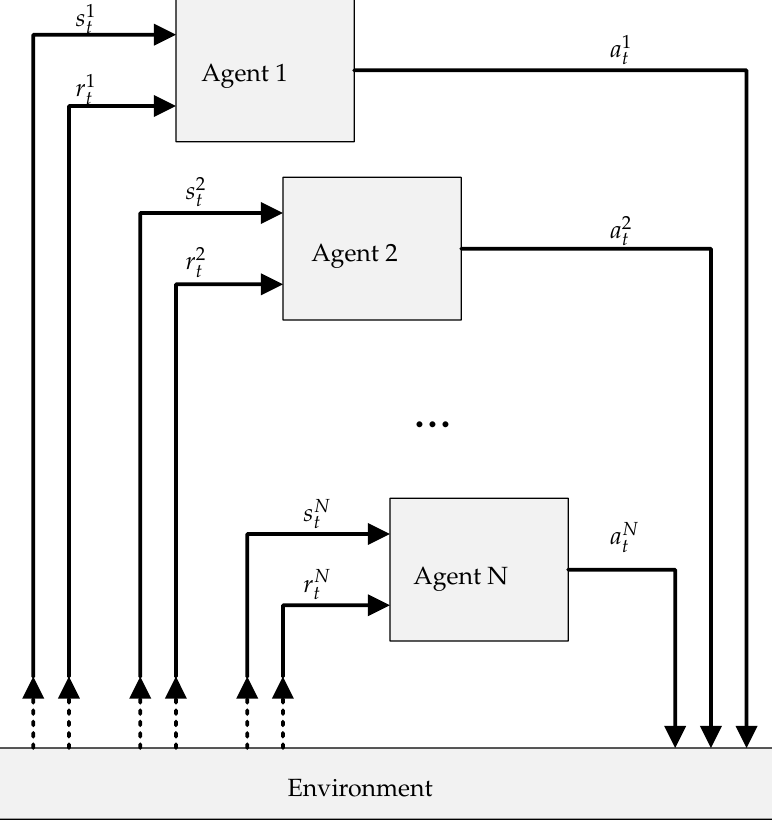
Figure 2. Simplified RL multi-agent